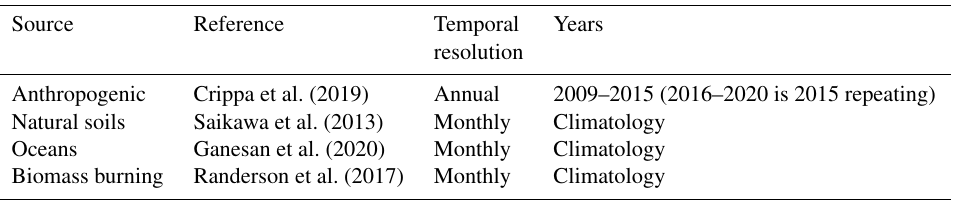
Table 2. Emissions inventories used for prior emissions in this